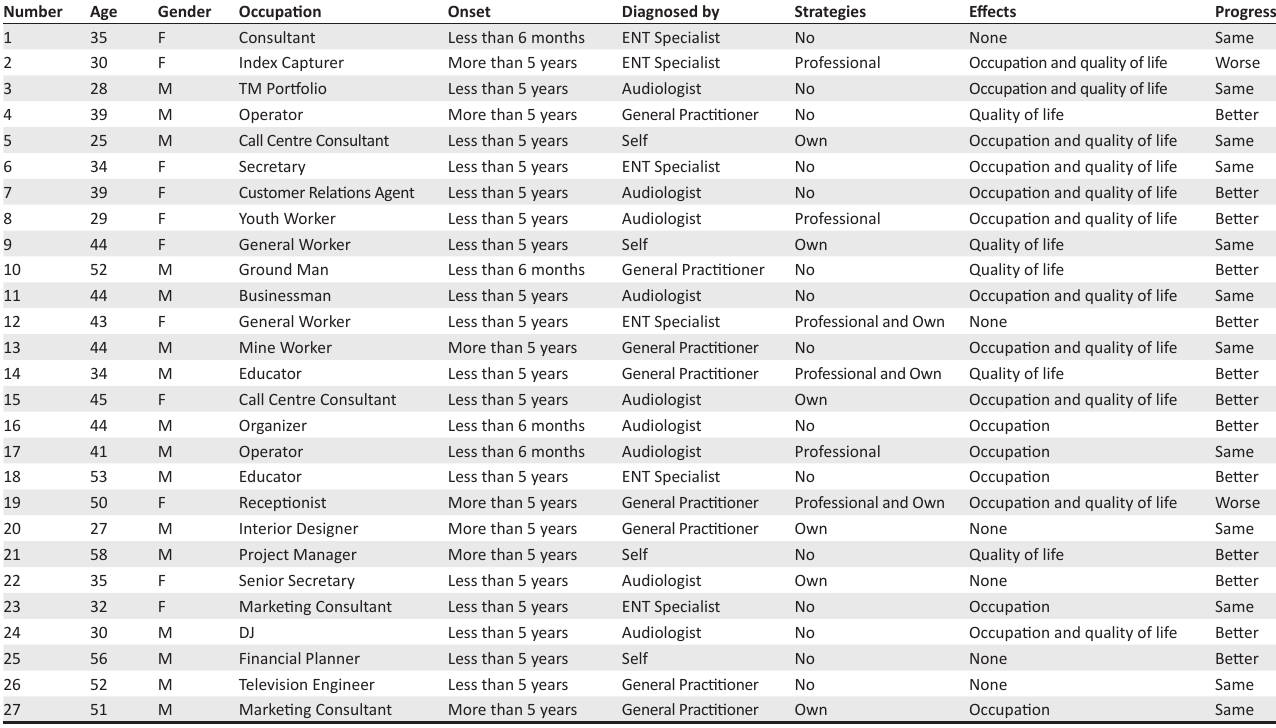
TABLE 1–A1: Profile of the